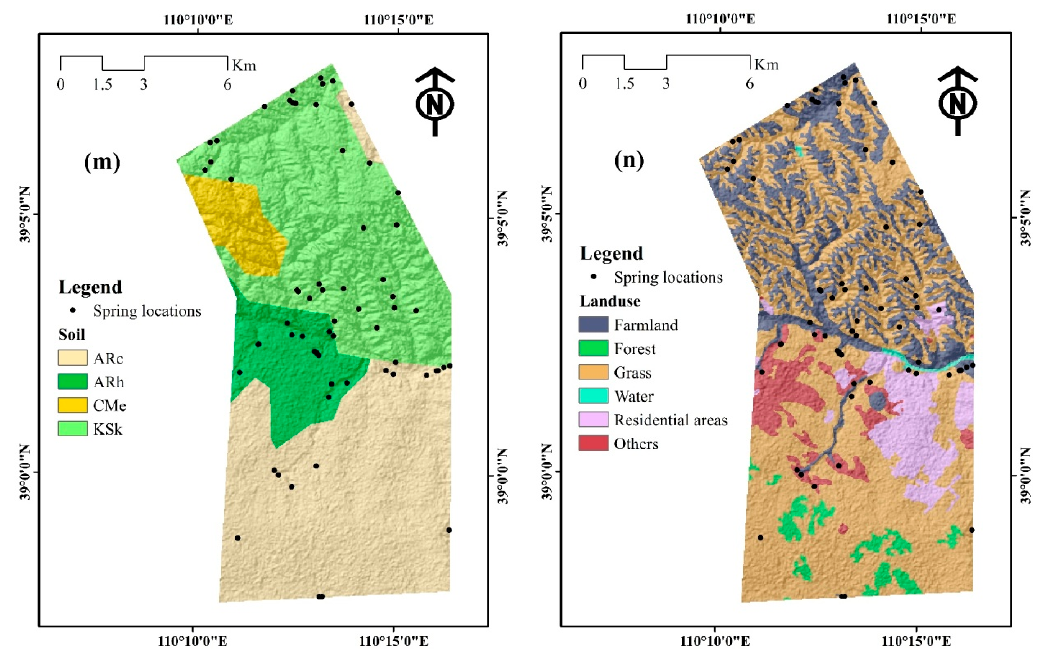
Figure 4. Thematic maps: ( a ) slope aspect; ( b ) slope angle; ( c ) plan curvature; ( d ) profile curvature; ( e ) elevation; ( f ) stream power index (SPI); ( g ) sediment transport index (STI); ( h ) topographic wetness index (TWI); ( i ) distance to streams; ( j ) distance to roads; ( k ) normalized difference vegetation index (NDVI); ( l ) lithology; ( m ) soil; ( n ) land use.